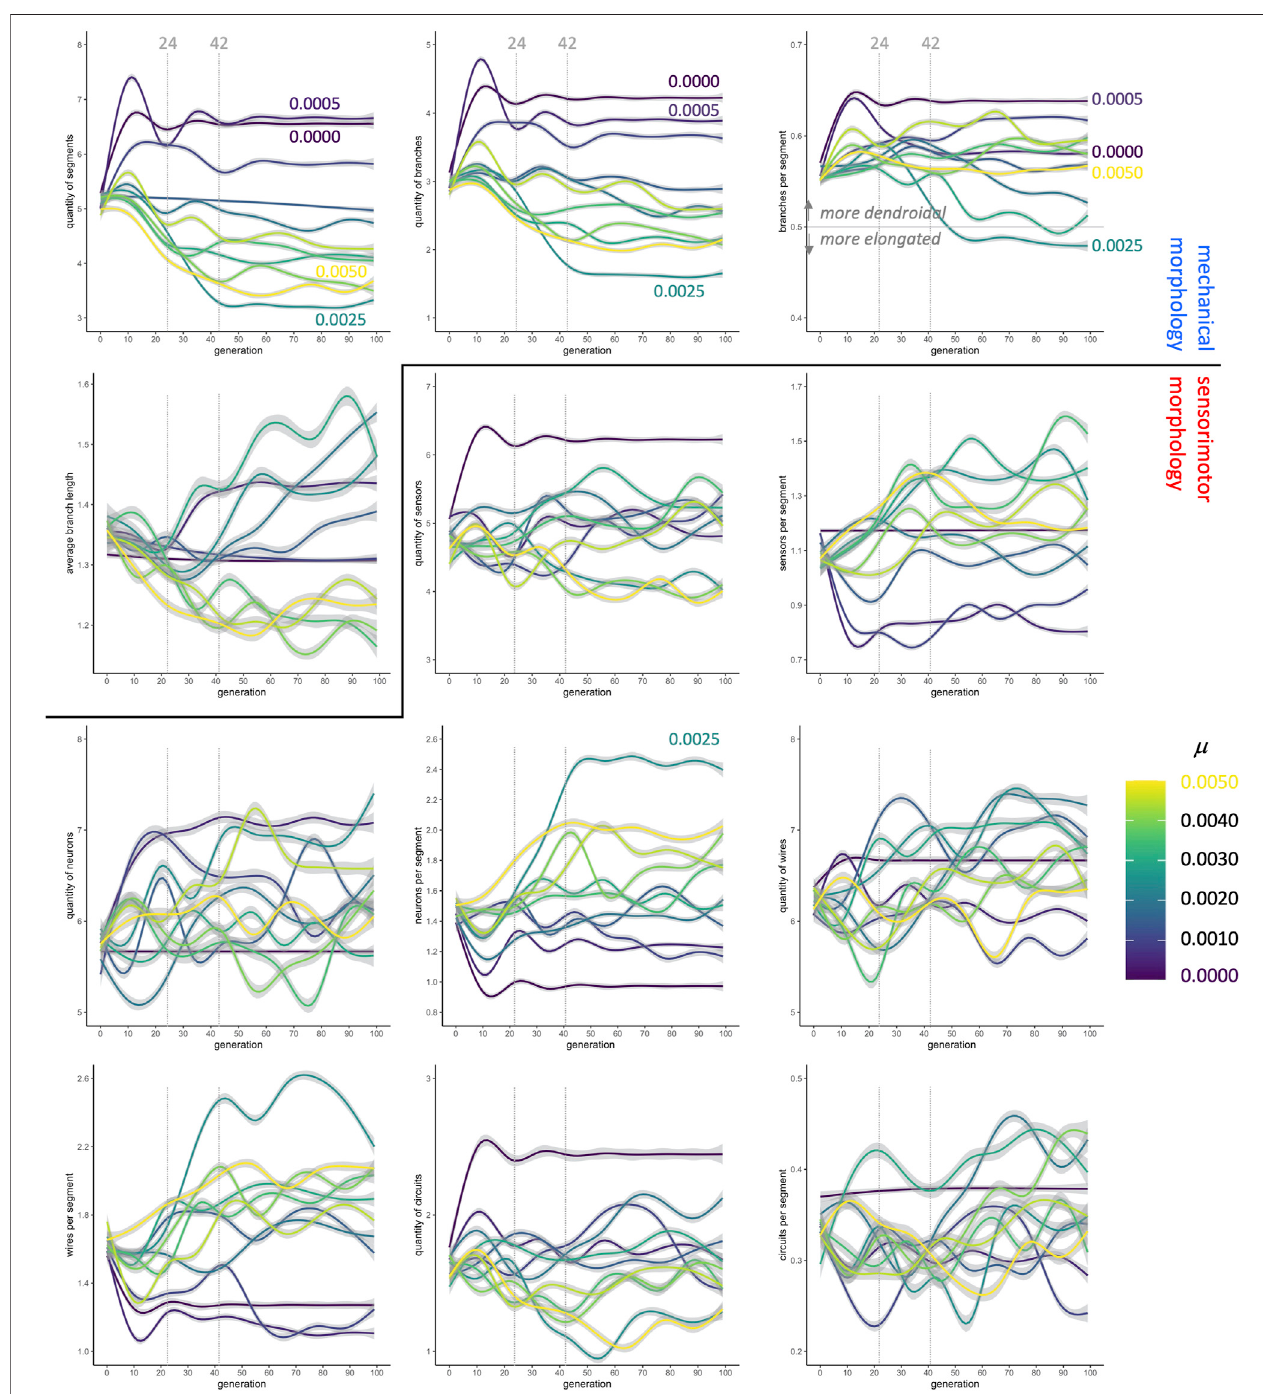
FIGURE 5 | Evolution of morphology as separate traits. The quantity of segments, the quantity of branches, and the ratio of branches to segments (top row) change dramatically in the fi rst 24 generations, stabilizing in most conditions by generation 42. In contrast, the sensorimotor morphologies, beginning with the neurons, are more variable over time and between conditions. Lines are means with gray 95% con fi dence